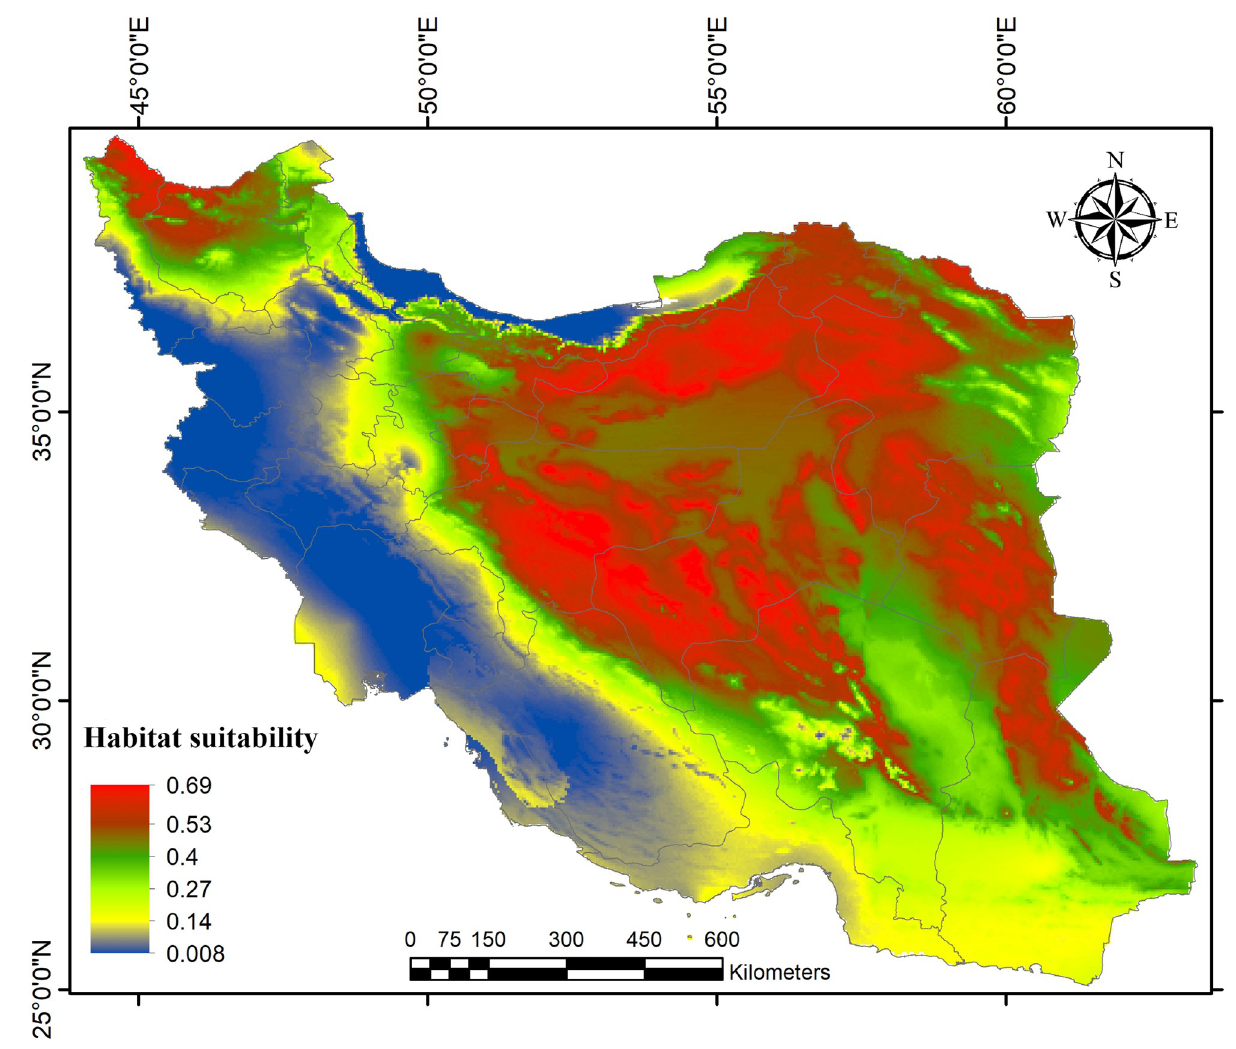
Fig 4. Predictive distribution map of Rhombomys opimus sargadensis in MAXENT models.